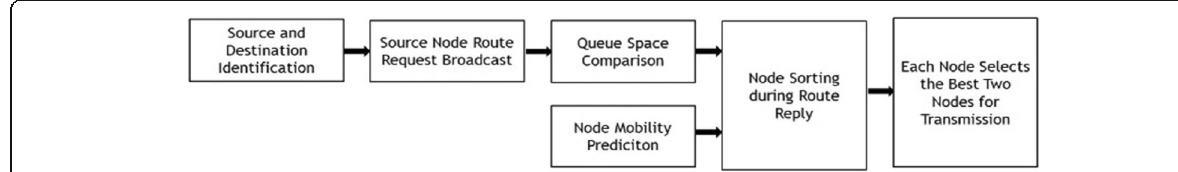
Fig. 2 Architectural model of LAPU. It explains the working process of LAPU